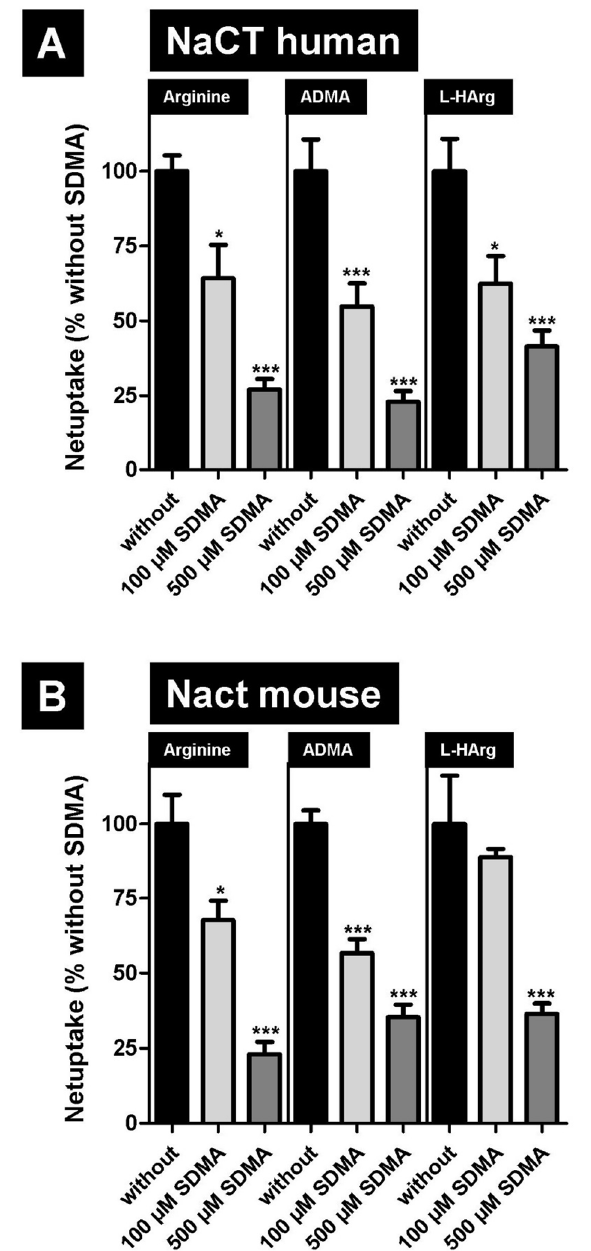
Figure 4. Inhibition of human ( A ) NaCT- and mouse ( B ) Nact-mediated arginine (50 µM), ADMA (50 µM), and L-homoarginine (50 µM) uptake by symmetric dimethylarginine (SDMA). SDMA was (50 µ M), and L-homoarginine (50 µ M) uptake by symmetric dimethylarginine (SDMA). SDMA was applied in two concentrations (100 µM—light grey bars and 500 µM—dark grey bars). Net uptake applied in two concentrations (100 µ M—light grey bars and 500 µ M—dark grey bars). Net uptake without added SDMA was set to 100% (black bars). * p > 0.01; *** p < 0.001 vs uptake without SDMA. without added SDMA was set to 100% (black bars). * p > 0.01; *** p < 0.001 vs. uptake without